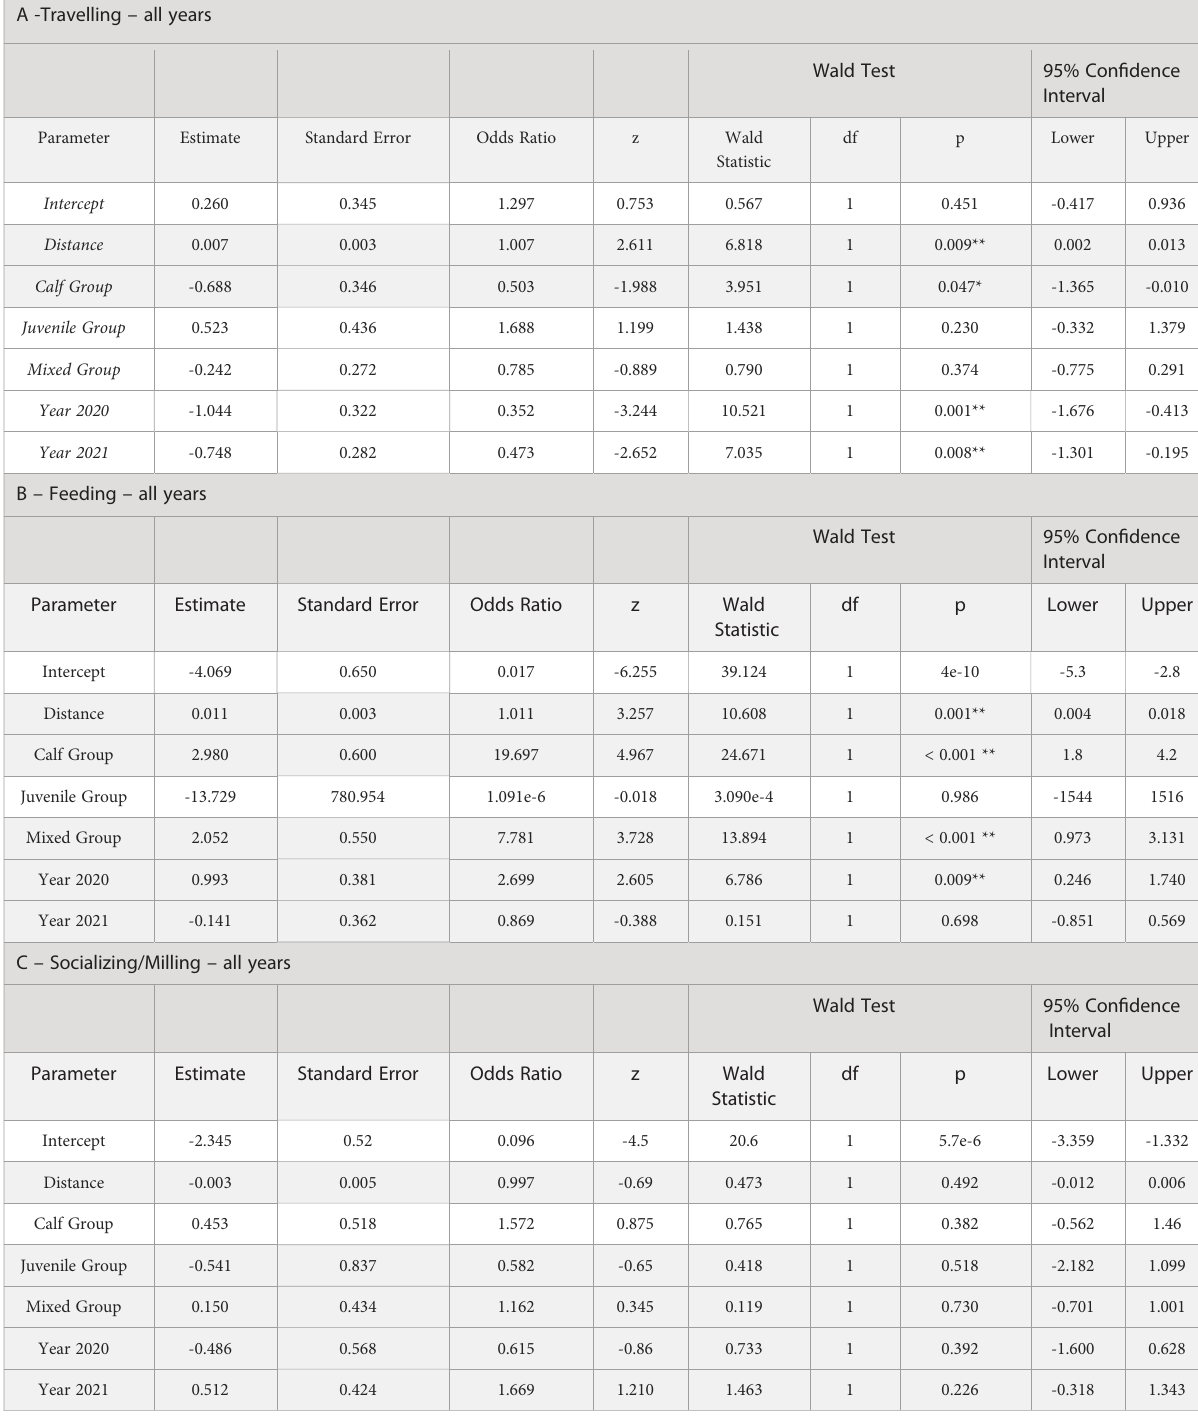
TABLE 8 Logistic regressions of behavioural frequencies observed from observation vessels, with Distance, Year and Age Group as explanatory variables: A -Travelling seen from Sea North II in 2019 and Zodiacs in 2019, 2020 & 2021; B- Feeding Sea North II and Zodiacs in 2019, 2020 & 2021; C- Socializing/Milling Sea North II and Zodiacs in 2019, 2020 & 2021 ( * =signi fi cant at p<0.05)